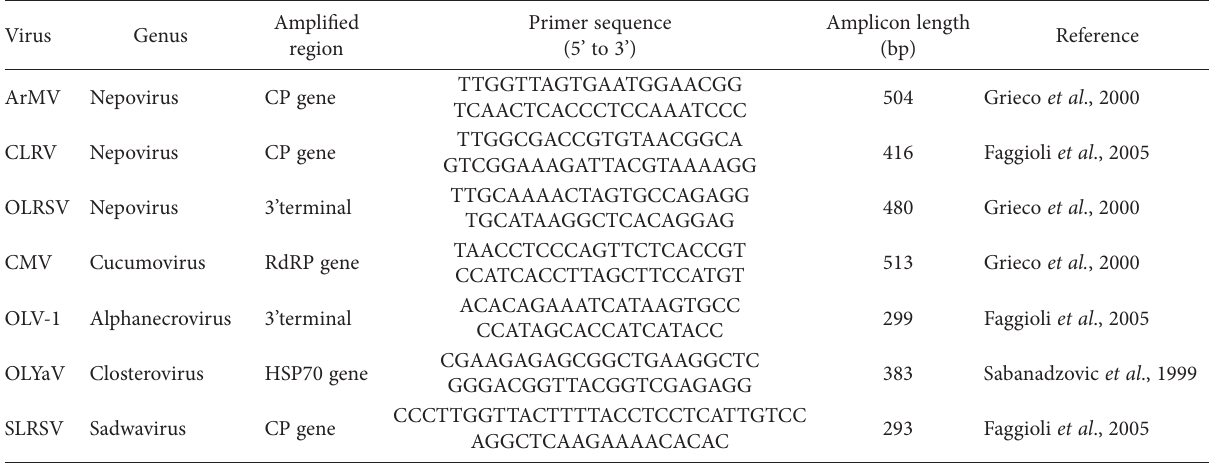
Table 2. List of primers used in RT-PCR assays for detecting the olive-infecting viruses. CP, Coat protein; RdRP, RNA-dependent RNA Polymerase; HSP70-like protein, Heat shock protein 70 kDa-like